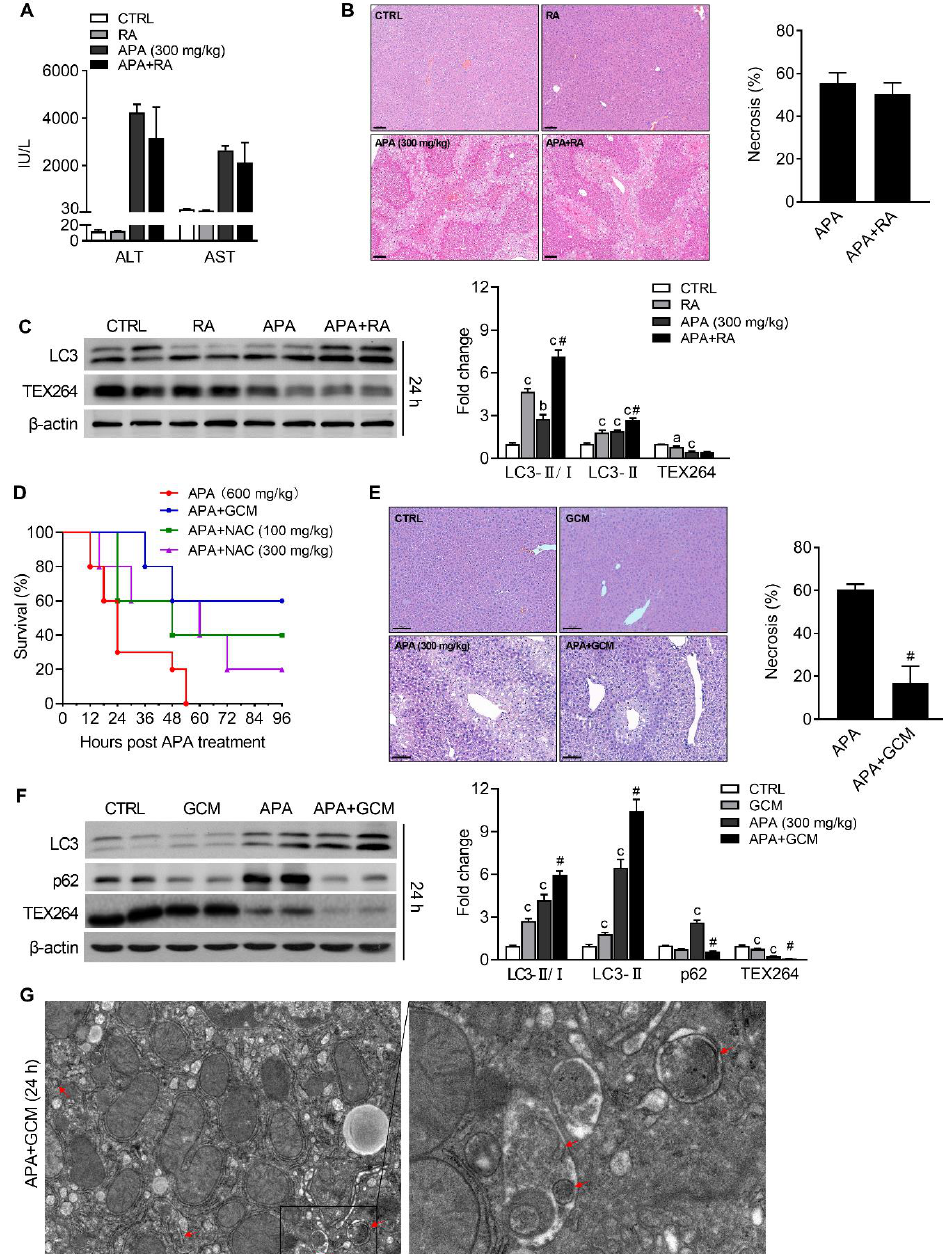
Figure 4. ER-phagy enhanced by GCM protects against APA-induced liver injuries. ( A – C ), Mice were treated with APA (300 mg/kg) followed by rapamycin (RA; 2 mg/kg) 6 and 18 h after APA. Blood and livers were harvested for analysis at 24 h. ( A ) Serum ALT and AST levels. ( B ) Representative H&E staining of liver tissues (left panel) and quantification of the centrilobular necrotic areas (right panel). ( C ) Immunoblot analysis for LC3, TEX264 (left panel) and the corresponding densitometry normalized to β-actin (right panel). ( D ) Mice were injected i.p. with GCM or NAC 6 h after a lethal dose of APA (600 mg/kg). Survival was evaluated for 96 h post-APA. ( E – G ) Mice were treated GCM (100 mg/kg) 6 and 18 h after APA (300 mg/kg) overdose. Livers were collected at 24 h. ( E ) Representative H&E staining of the liver tissues (left panel) and the quantification of centrilobular necrotic areas (right panel). Scale bar = 100 µ m. ( F ) Immunoblot analysis for LC3, p62 and TEX264 (left panel) and the corresponding densitometry normalized to β -actin (right panel). ( G ) Representative TEM images of hepatocytes in mice livers at 24 h following the APA and GCM treatments. Scale bar = 400 nm. Arrows denote ER-selective autophagosomes. Data are presented as the mean ± SEM. a: p < 0.05, b: p < 0.01 and c: p < 0.001 compared with the vehicle control. # p < 0.05 compared with the corresponding APA-treated